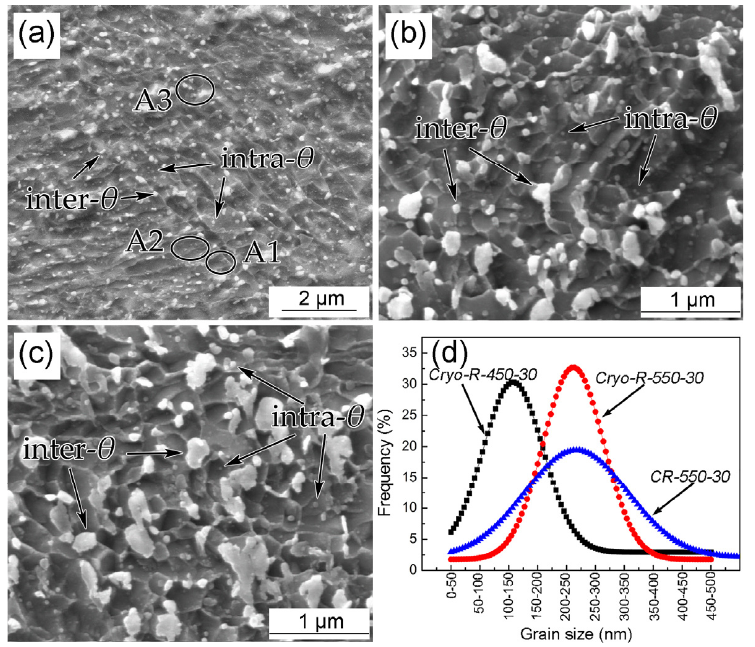
Figure 4. SEM micrographs of α + θ phases in the specimens ( a ) CR–550–30, ( b ) Cryo–R–450–30 and ( c ) Cryo–R–550–30 and ( d ) corresponding size distribution of α grains.